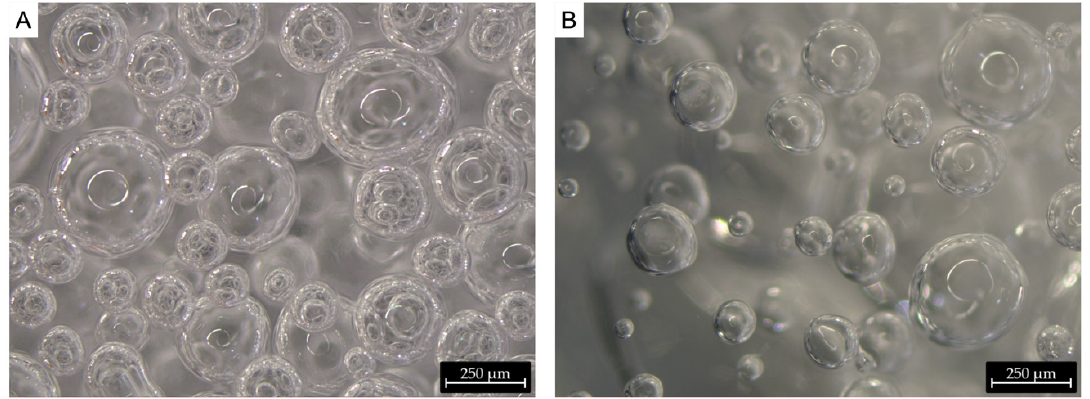
Figure 3. Stereomicroscopy (5× magn). Agar foam 2 min. after preparation ( A ) CO 2 , and ( B ) N 2 O.